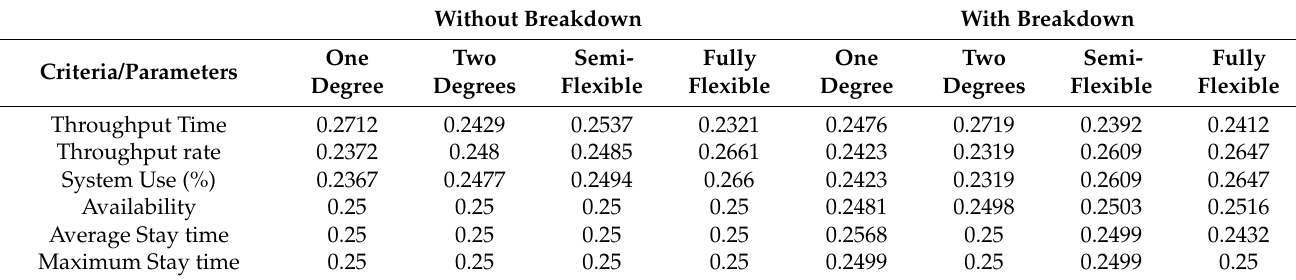
Table 8. Normalized matrix for the collected values of the